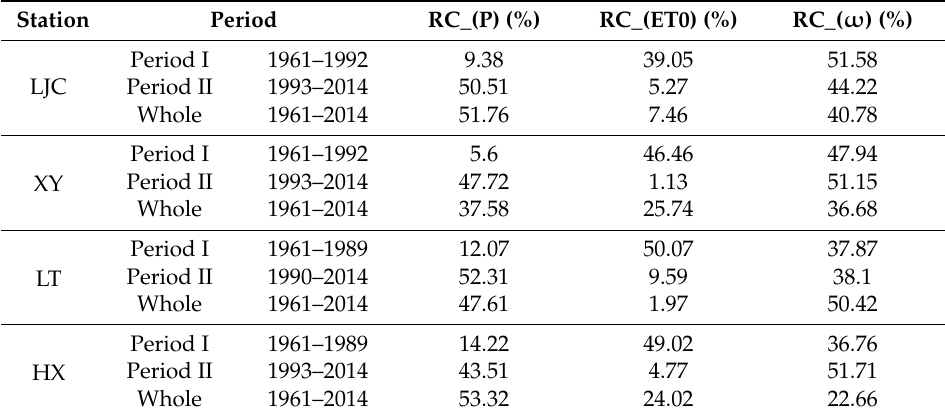
Table 3. Contributions of P, ET 0 , and ω to changes in